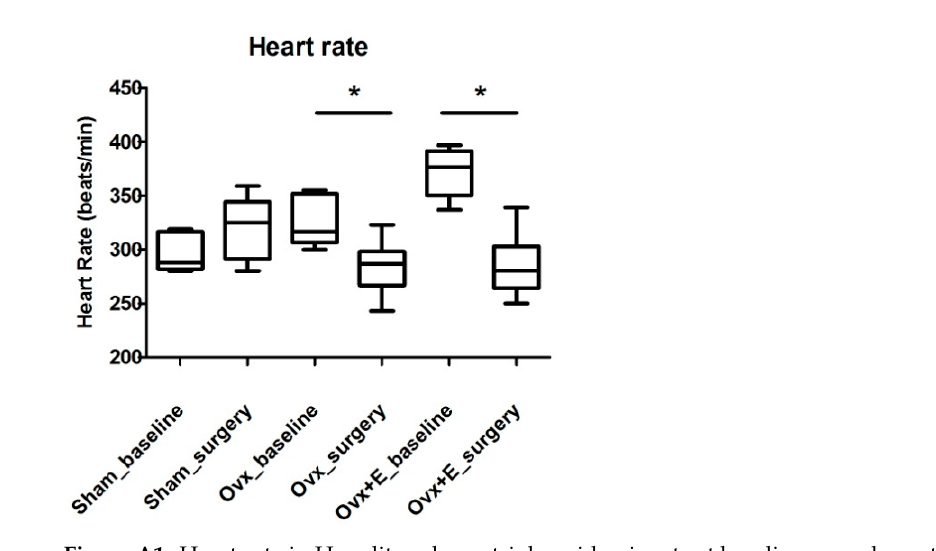
Figure A1. Heart rate in Hereditary hypertriglyceridemic rats at baseline vs. values at the end of the study. Legend: Sham_baseline: sham group before surgery; sham_surgery: sham group after surgery ( n = 5); Ovx_baseline: ovariectomized group before surgery; Ovx_surgery: ovariectomized group after surgery ( n = 6); Ovx+E_baseline: ovariectomized group with estradiol substitution before surgery; Ovx+E_surgery: ovariectomized group with estradiol substitution after surgery ( n = 6). Evaluated by one-way ANOVA and Fisher LSD post-hoc test; n.s.: nonsignificant, * p < 0.05.